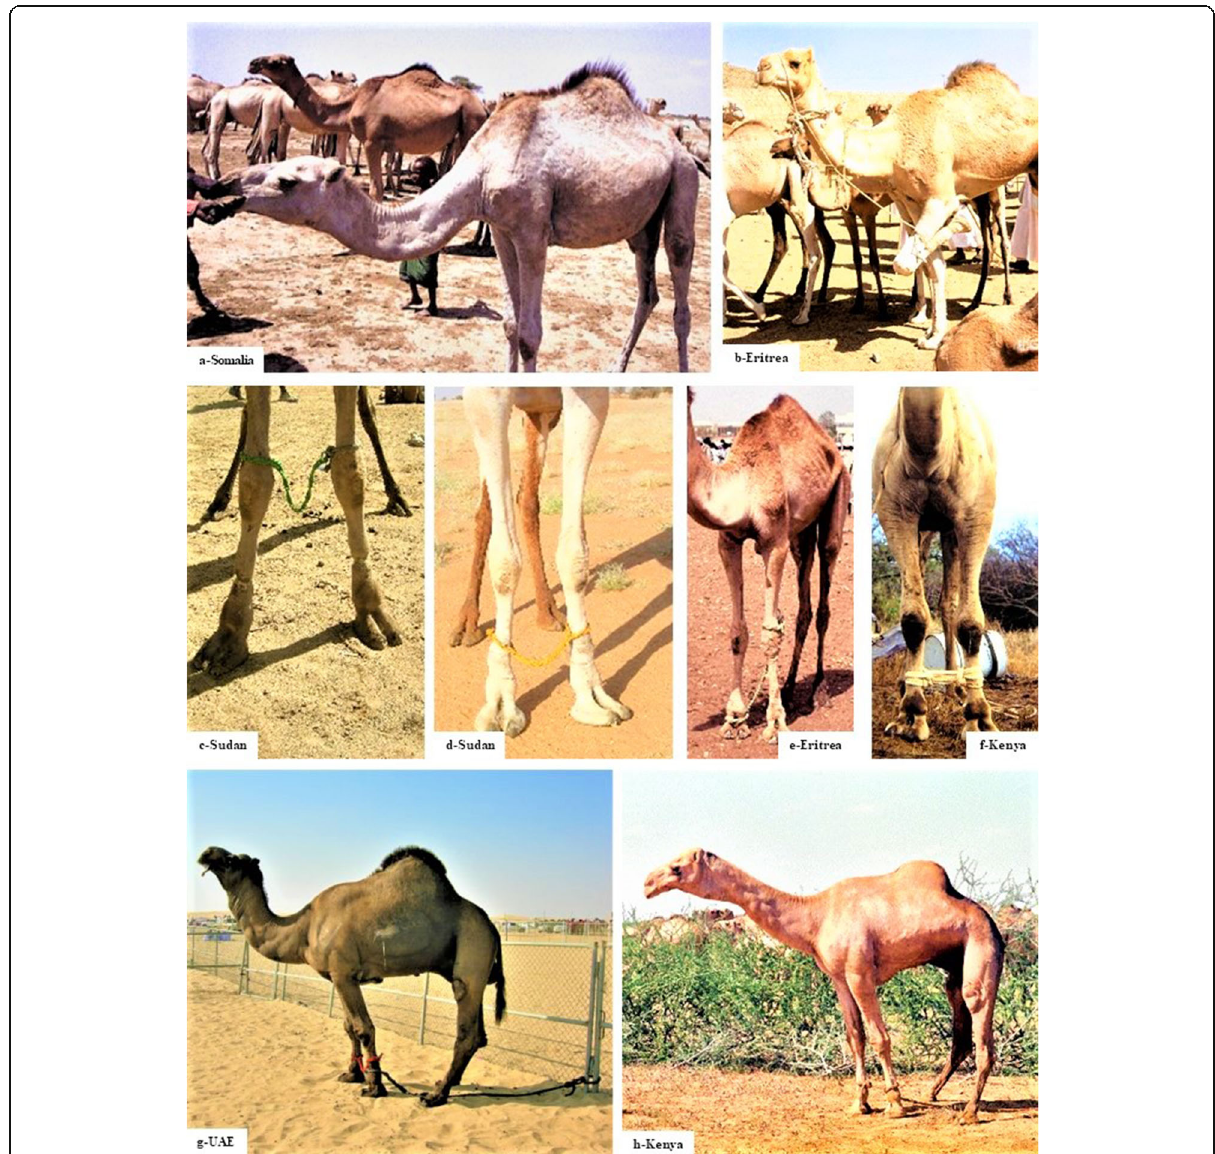
Fig. 1 Images of various camel restraints and control practices used by nomadic camel pastoralists in a variety of countries (Dioli 2012, 2013, Schwartz and Dioli 1992). a Somalia. b , e Eritrea. c , d Sudan. f , h Kenya. g